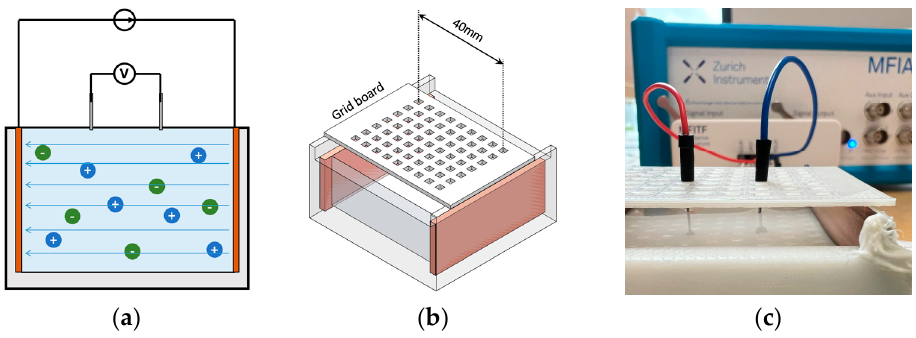
Figure 8. Four ‐ electrode conductivity measurement: ( a ) the principle of the four ‐ electrodes method; Figure 8. Four-electrode conductivity measurement: ( a ) the principle of the four-electrodes method; ( b ) 3D schematic of the setup; ( c ) experimental setup for NaCl solution samples. ( b ) 3D schematic of the setup; ( c ) experimental setup for NaCl solution